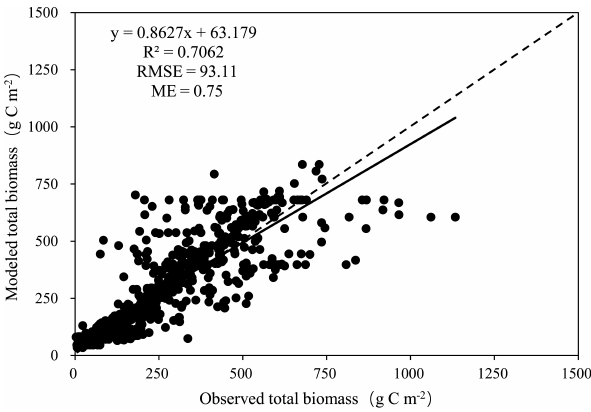
Figure 3. Comparison of the modeled and observed SOC concen- trations